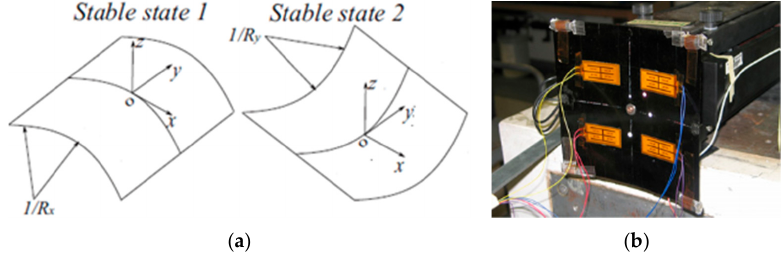
Figure 15. Scheme of a bistable carbon fibre plate ( a ) and PZT patches attached on the executed plate ( b ) [117]–reprinted by permission from AIP Publishing.